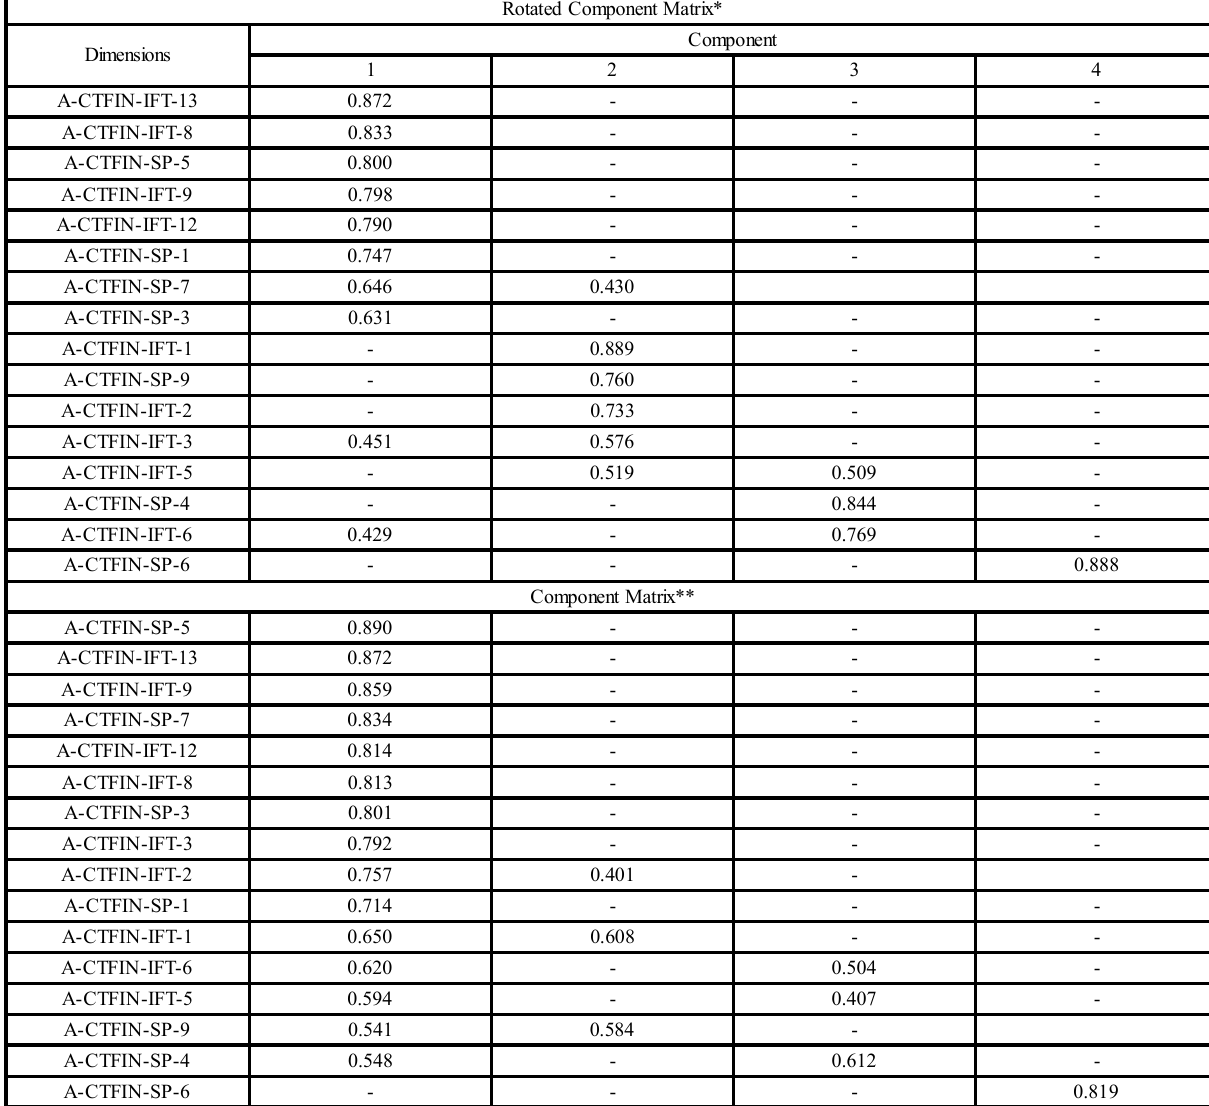
TABLE 14. DETAILS OF FACTOR EXTRACTION (ORTHOGONAL VARIMAX ROTATION WITH FOUR FACTORS)